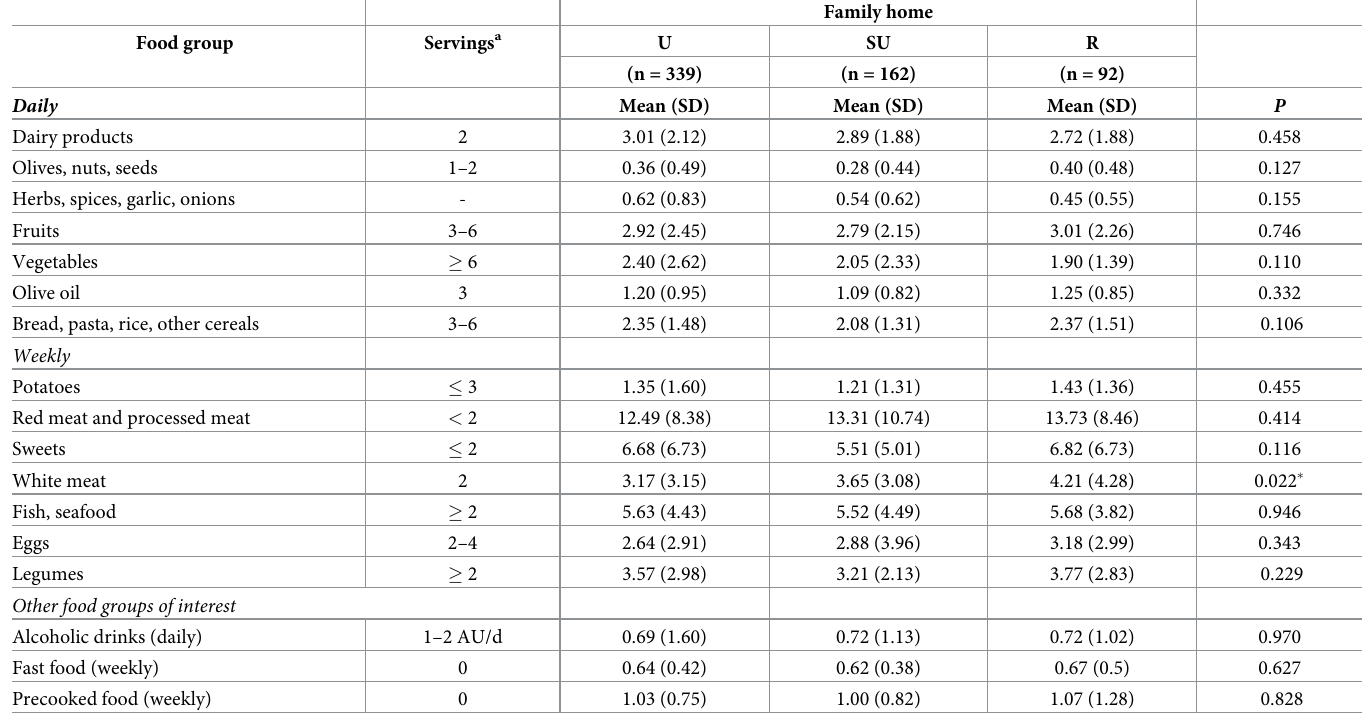
Table 4. Mean differences in food group consumption by location of the family home ( n =